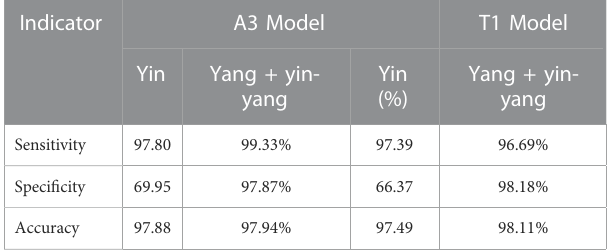
compare the performance of the different methods. The results showed that the XGBoost and random forest models outperformed the SVM and logistic models in terms of accuracy and other metrics. (Supplementary Table S4).